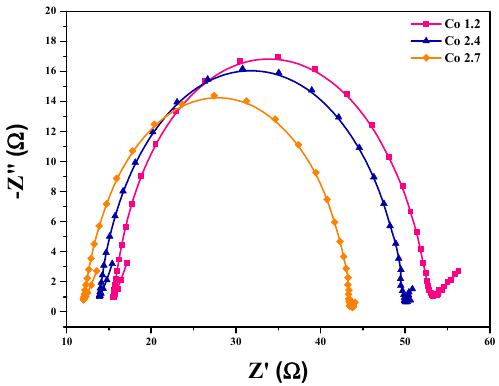
Figure 8. Nyquist plots of Co- and Mn-based the mixed phase materials (Co = 1.2, 2.4 and 2.7) in the frequency range from 0.1 to 100 kHz. A sinusoidal voltage with an amplitude of 5 mV was applied.